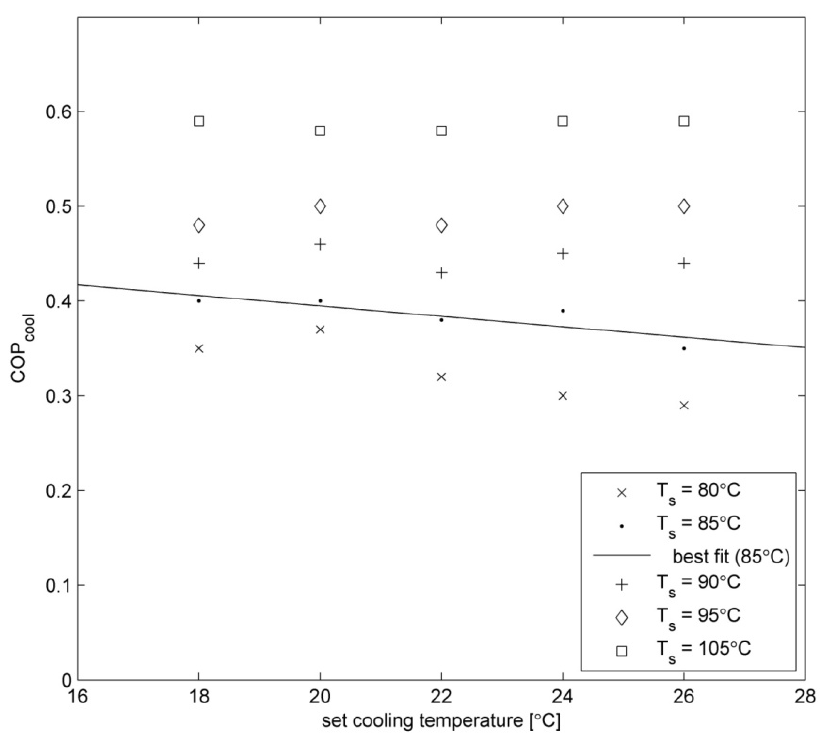
Figure 7. COP against cooling temperature for 20 °C heat sink